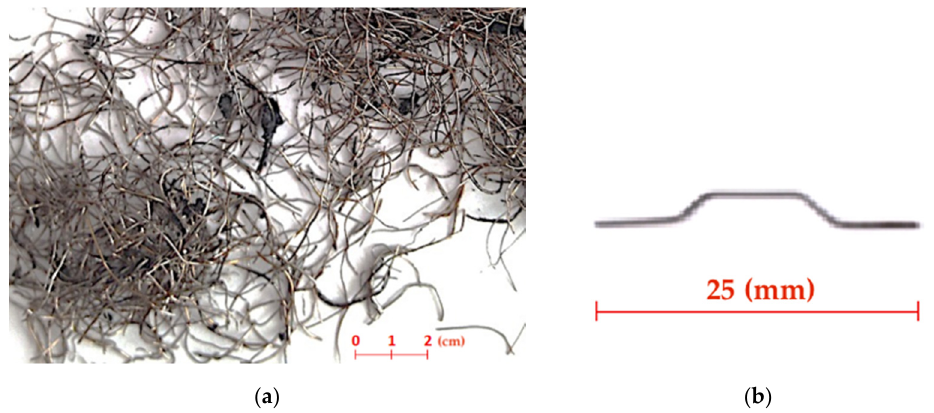
Figure 1. ( a ) Recycled steel fibres (RSF) derived in KAHL technology (ambient grinding method). ( b ) Industrial produced steel fibres (ISF).